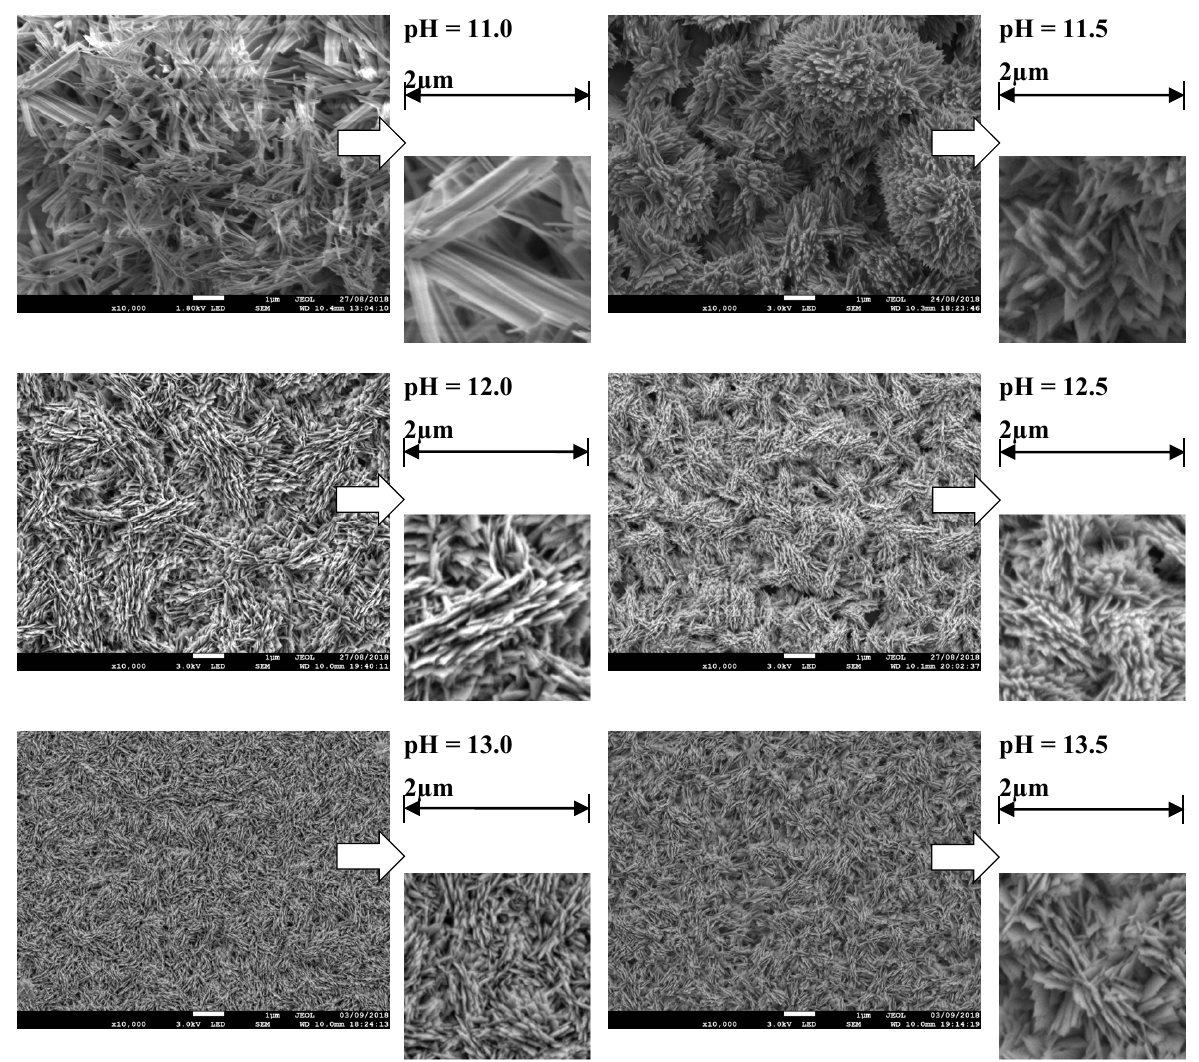
Figure 4. SEM images of the as-prepared MWCBD-CuO films at different pH values. The 11 to 13.5 range of pH with steps of 0.5 in the aqueous solution modified the surface morphology of the CuO films, this could have originated from the solubility changes and the influence of the zinc-hydroxy complexes. For example, the Cu ( OH ) 0 2 species dominate at pH = 11, the Cu ( OH ) − and Cu ( OH ) 2 − species begin to increase at 3 4 pH > 11.5, as observed in the SDDs with changes in solubility (see Figures 1 and 2). The crystalline structure and surface morphologies obtained at pH > 11.5 values can be achieved by adding OH − ions through NH 4 OH until reaching the desired pH value. More OH − ions make the Cu ( OH ) − and Cu ( OH ) 2 − (growth units) species appear in the SDDs, and 3 4 major solubility changes are observed in the SDs. This excess of OH − ions produces a vertical growth of the pointed end sheets aligned to the z -axis on the CuO